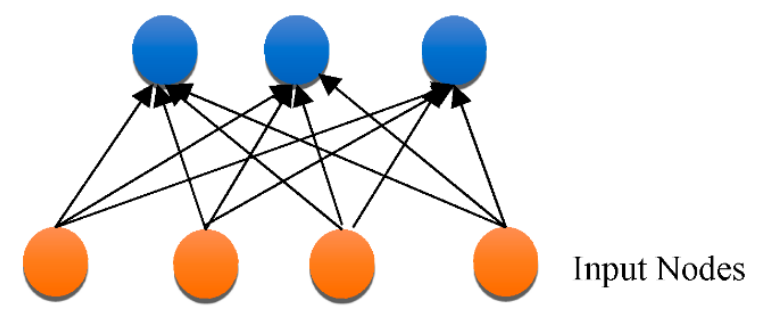
Figure 4. Architecture of RBM .